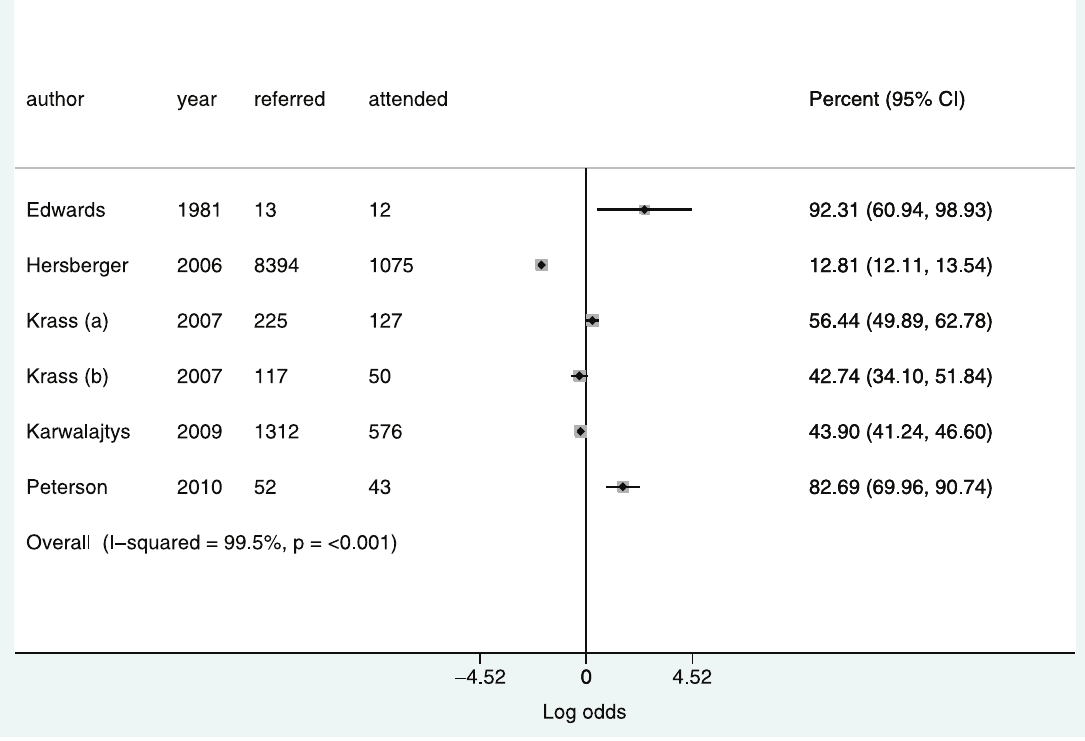
Figure 3. Percentage uptake of a referral to a general practitioner.